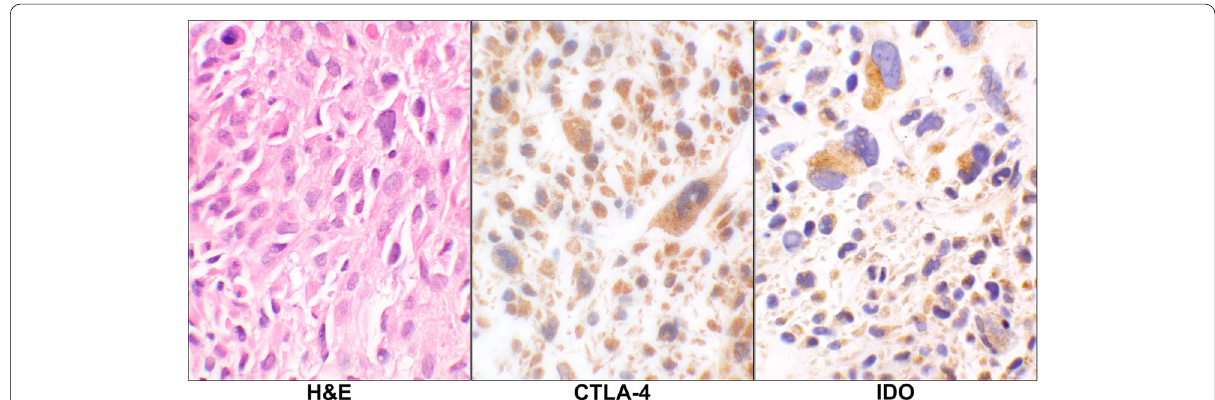
Fig. 3 CTLA-4 and IDO reactions in Leiomyosarcoma. H&E stain of a case of primary leiomyosarcoma showing pleomorphic malignant cells (case# 17, Additional Table 1). The corresponding CTLA-4 and IDO IHC stains show positive granular cytoplasmic staining of the malignant cells. (40 objective). Abbreviations: H&E, hematoxylin & eosin; CTLA-4, cytotoxic T lymphocyte antigen 4; IDO, indolaimine-2, 3-deoxygenase; IHC, × immunohistochemistry